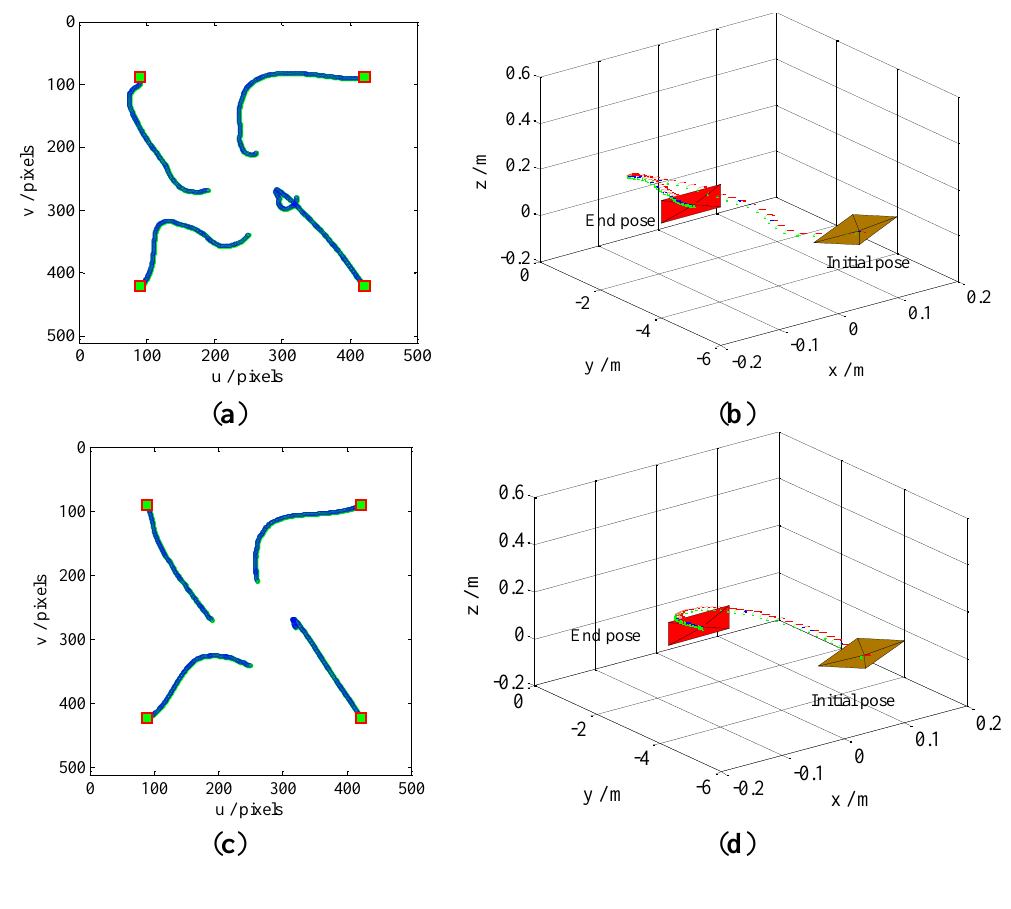
Figure 9. Comparison of our method with KBF for Case 3. The additive noises are set at zero mean, and variances are set at 1 × 10 −3 . ( a ) Features trajectories by KBF; ( b ) Camera trajectory by KBF, camera with slight retreat; ( c ) Feature trajectories by our method; ( d ) Camera trajectory by our method, camera without